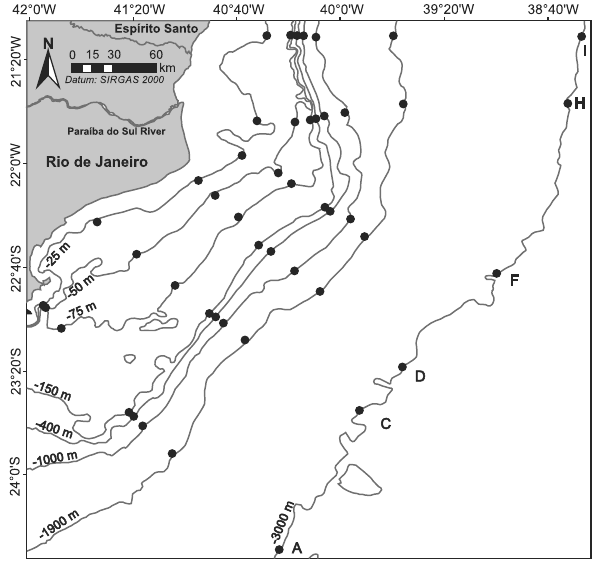
Figure 1. Sampling stations off the central Brazilian coast surveyed in this study. Lines indicate isobaths and letters indicate